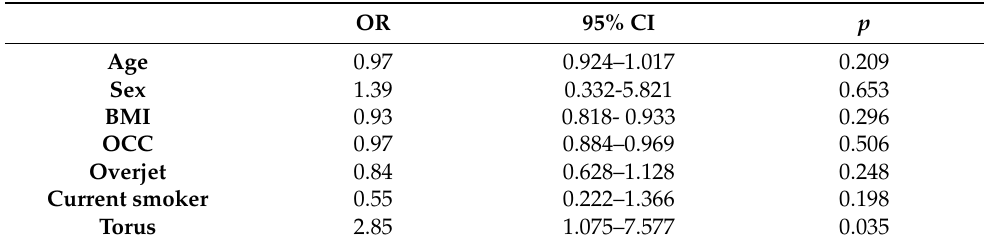
OR, odds ratio; CI, confidence interval 95%. See abbreviations Table 1. Table 6. Multivariate analysis of the OR of effectiveness of the MAD intervention. Model 1. OR 95% CI p OR